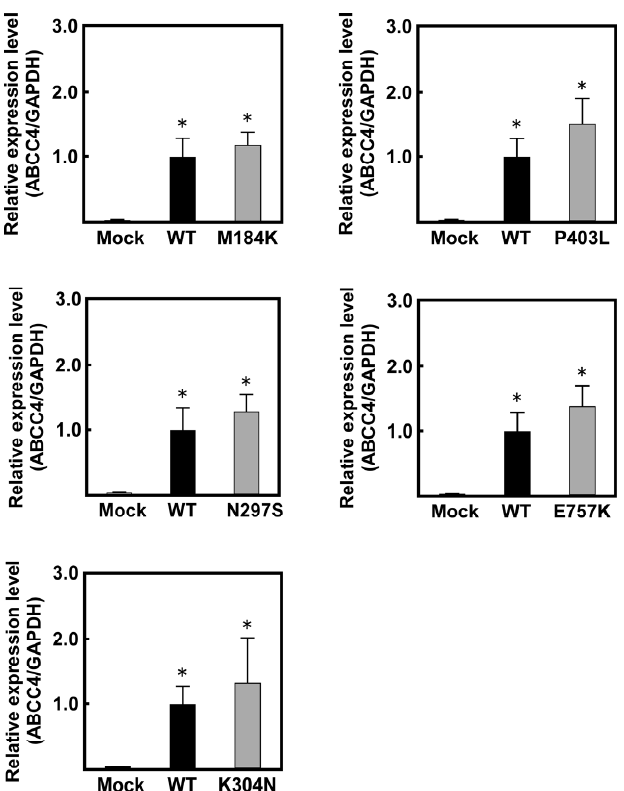
Figure 2. Levels of ABCC4 mRNA in cells established using the Flp-In™ system. The levels of ABCC4 and GAPDH mRNA were measured using qPCR with specific primer sets for ABCC4 and GAPDH ,